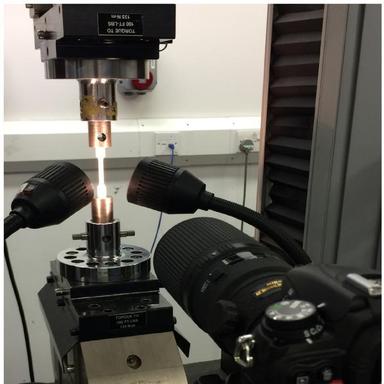
Experimental rig used for the specimen's neck geometry monitoring.